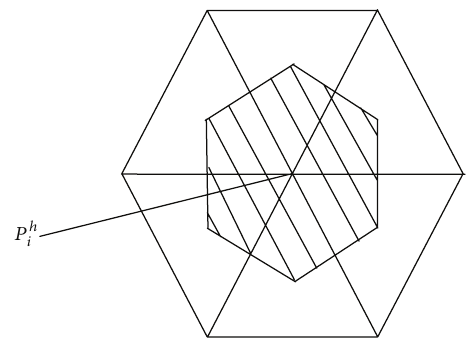
Figure 1: The lumped mass region Ω ℎ 𝑖 at 𝑃 ℎ 𝑖